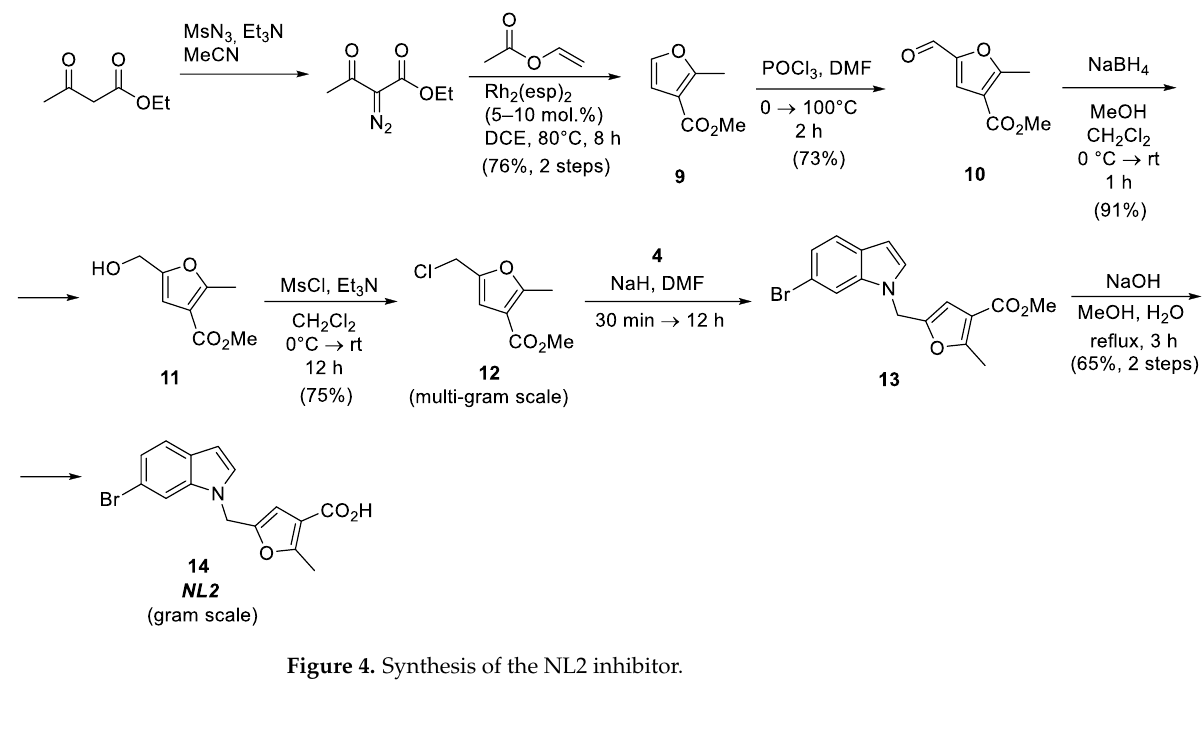
Figure 4. Synthesis of the NL2 inhibitor.